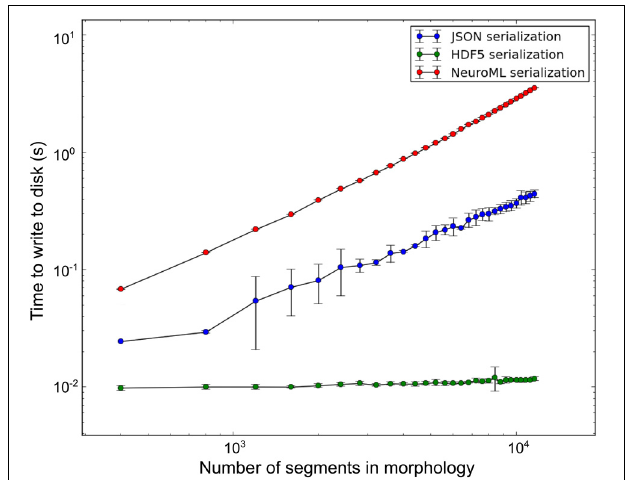
FIGURE 6 | Disk write time for synthetic morphologies in different serialization formats. Error bars represent one standard deviation (sample size =